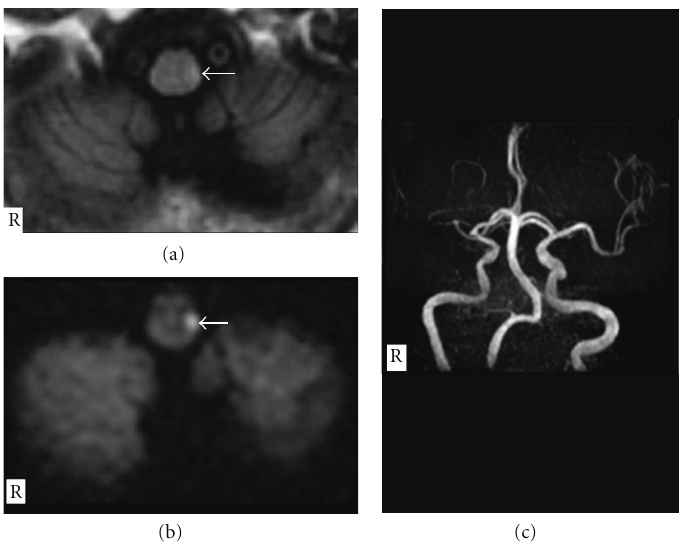
Figure 1: (a) Fluid-attenuated inversion recovery image and (b) di ff usion-weighted image of cranial magnetic resonance imaging on the axial images demonstrated a small infarct lesion in the lower lateral medulla oblongata on the left side (arrow). (c) Cranial magnetic resonance angiography demonstrated an absence of flow of the left vertebral